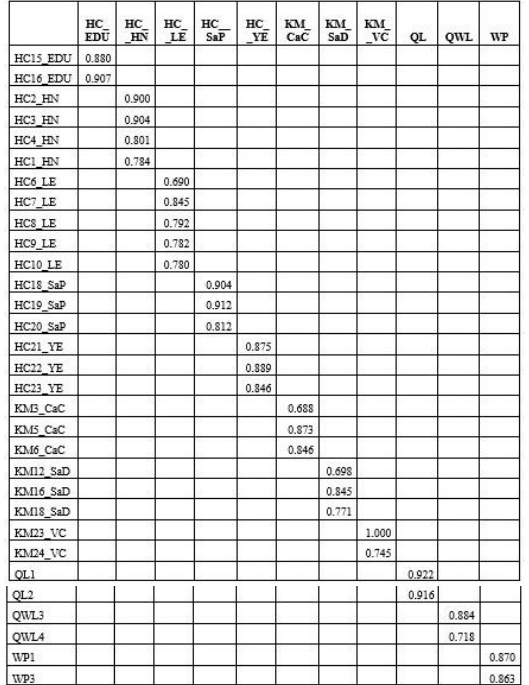
Table 1: Quality of the First-Order Constructs-Factor Loadings